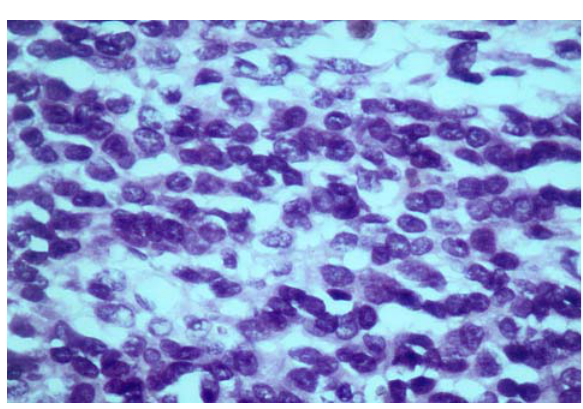
Figure 2 – Histological analysis showing a monotonous pattern of small round cells (HE, X400).